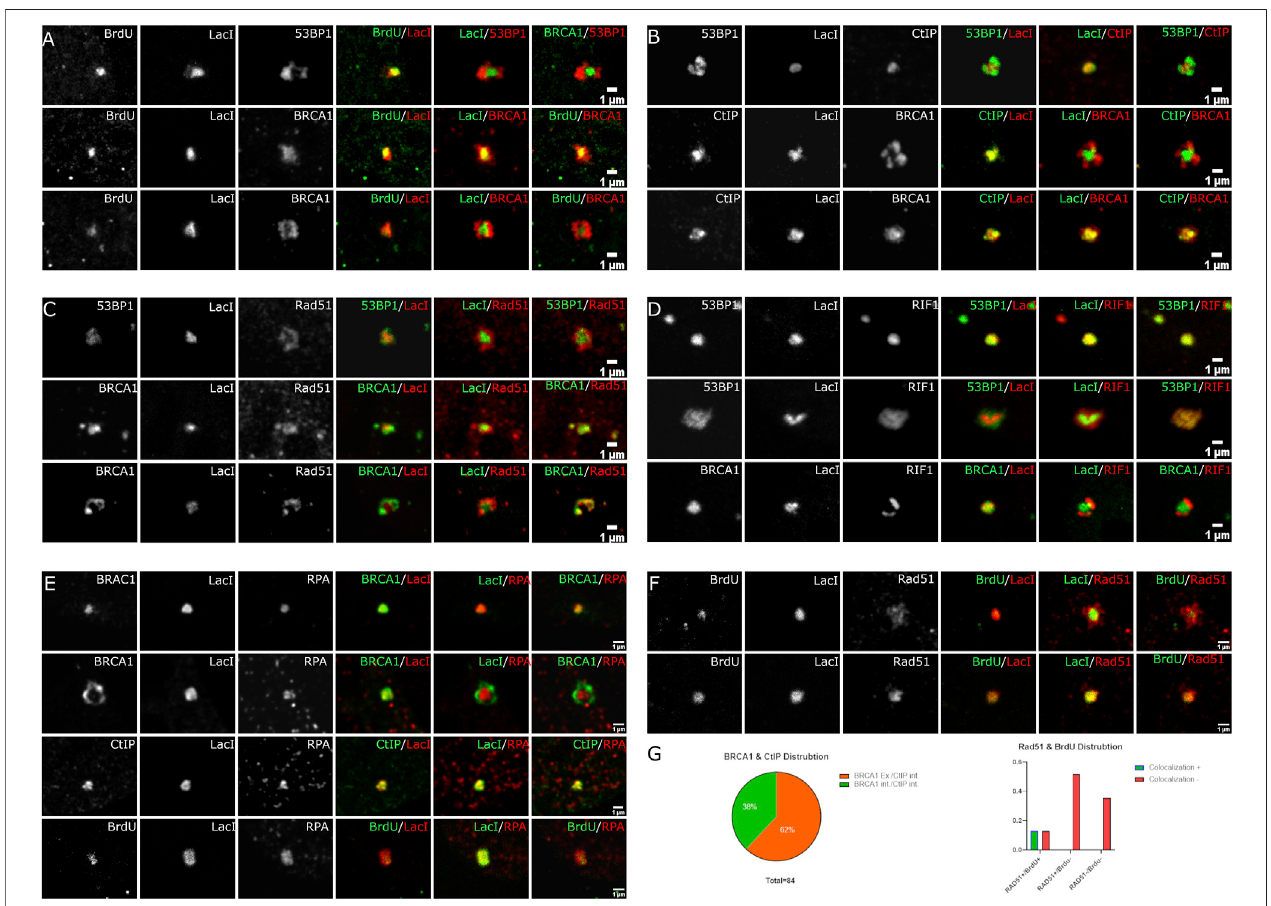
FIGURE 5 | Spatial localization of BrdU labeling, CtIP, RAD51, Rif1, and RPA relative to LacI and the DSB compartment. U2OS 265 Fok1 induced DSB and fi xed 1 h post-treatment and stained with antibodies recognizing 53BP1, BRCA1, BrdU, CtIP, Rad51, Rif1, and RPA. For the BrdU experiment, cells were labeled with BrdU for 18 h prior to treatment with Shield1 and 4-OHT. (A) BrdU distribution is compared to LacI. (B) CtIP localization is compared to LacI. Recruitment of Rad51 versus 53BP1 and BRCA1 relative to LacI (C) and Rif1 recruitment relative to 53BP1, BRCA1, and LacI (D) . (E) Localization of RPA compared with BRCA1, CtIP, and BrdU. (F) Different occupancy ofRad51 relative to end resection. (G) BRCA1 and CtIP distribution at DSB sites. BRCA1 exterior and CtIP interior versus BRCA1 interior and CtIP interior localizing to LacI. Rad51 and BrdU colocalization at the site of DNA break. The scale bar represents 1 µm.